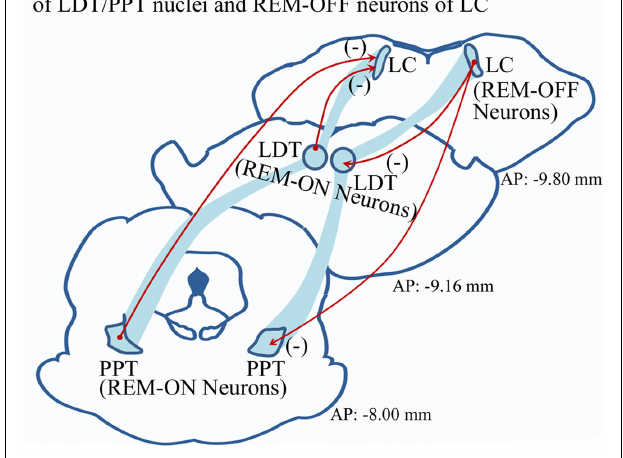
FIGURE 1 |Widely accepted model of reciprocal interaction between aminergic REM-OFF neurons of LC and cholinergic REM-ON cells of LDT and PPT. It has been proposed that activated LC REM-OFF cells inhibit REM-ON neurons in LDT and PPT, which does not allow REM sleep to occur. Hyperpolarization of REM-OFF cells in turn causes disinhibition of REM-ON neurons, which may initiate REM sleep. (Abbreviation – LC, locus coeruleus; LDT, latero-dorsal tegmentum; PPT, pedunculopontine tegmentum; ( − ), inhibitory